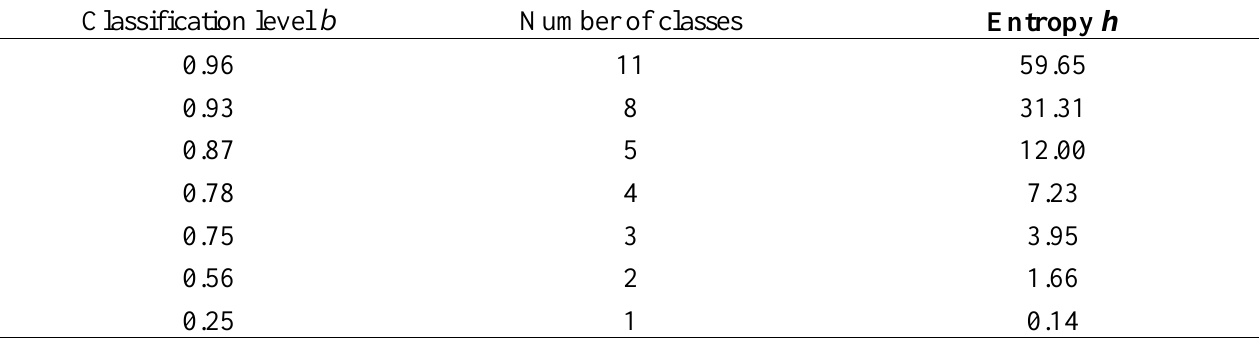
Table 2. Classification level, number of classes and entropy for the local